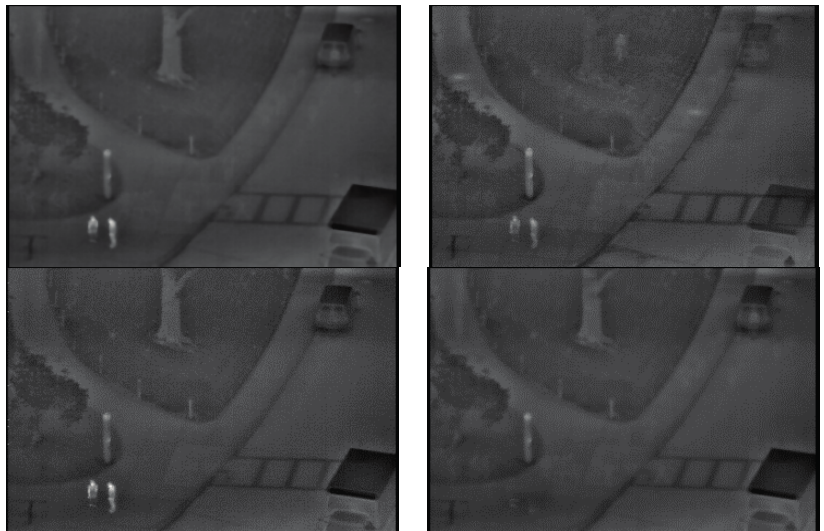
Figure 11. In the previous method [28], they obtained a background image using a simple averaging operation. In [26], they obtained a background image by averaging the frames in two different sequences.